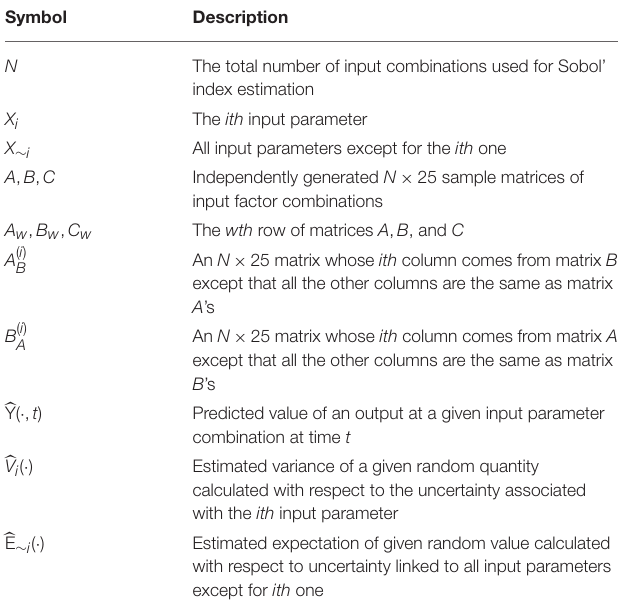
TABLE 4 | Notation used for estimating Sobol’ indices.